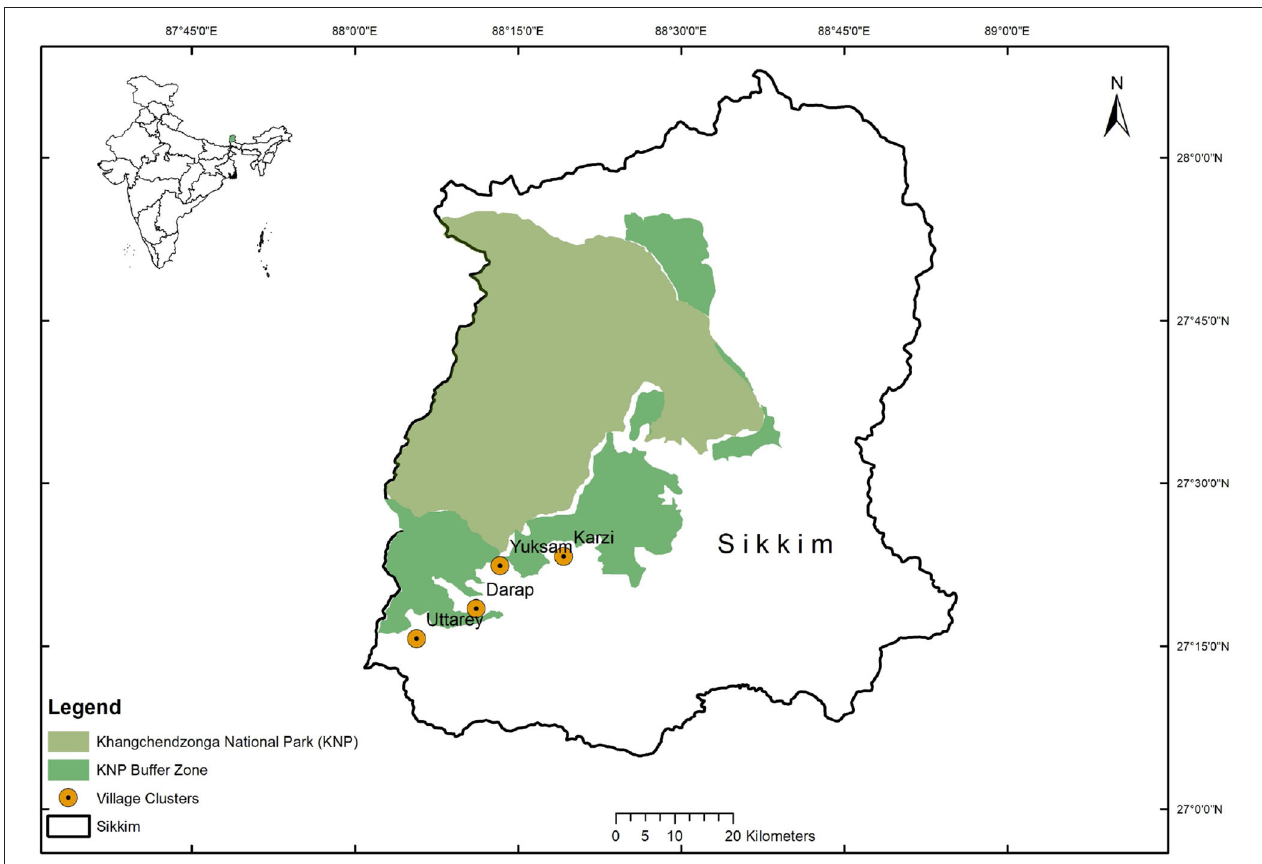
FIGURE 1 | Map highlighting Khangchendzonga National Park (KNP) and the location of four village clusters in the study area.